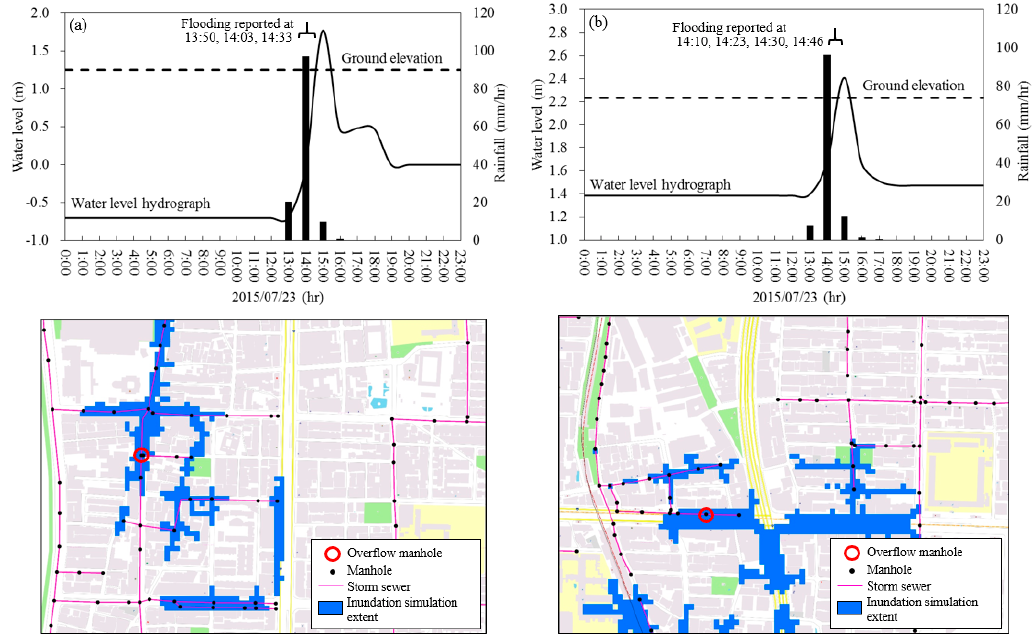
Figure 5. Simulated flood inundation depth and extent during Heavy rain 0723 (2015) in ( a ) Datong district and ( b ) Zhongshan district.